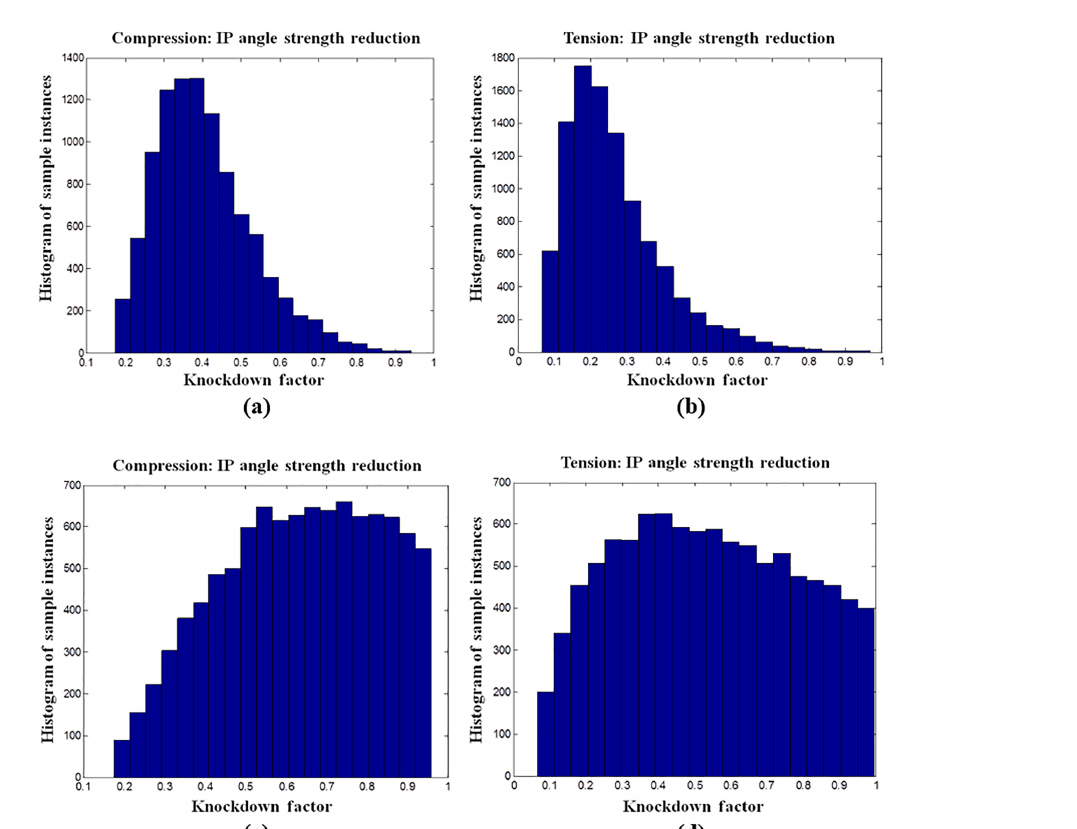
Figure 18. Strength reduction sample sets as a function of flaw magnitude distributions for the following: Case 1 in compression (a) , Case 1 in tension (b) , Case 2 in compression (c) , and Case 2 in tension (d)